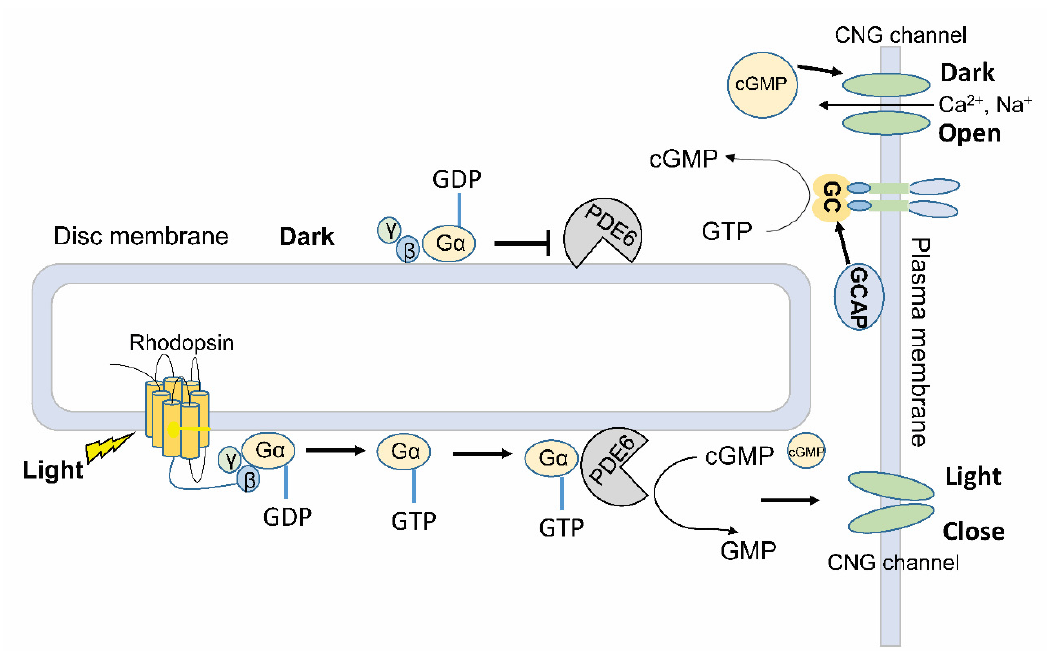
Figure 2. PDE6 is involved in the phototransduction of vertebrate visual system. The disc membrane and plasma membrane depicted here are localized in photoreceptor cells of retina. Key proteins related to phototransduction cascades are shown in the membranes. The photosensor rhodopsin is integrated into the disc membrane, where G proteins (G α , β , γ ) and PDE6 are attached. In the plasma membrane, CNG channels permeable to Ca 2+ and Na + stay in an open or close state depending on the dark or light conditions. GC and GCAP are shown in the plasma membrane to maintain the cellular cGMP levels. G proteins: guanine nucleotide-binding protein; GDP: guanosine diphosphate; GTP: guanosine triphosphate; GMP: guanosine monophosphate; GCAP: guanylate cyclase-activating proteins.